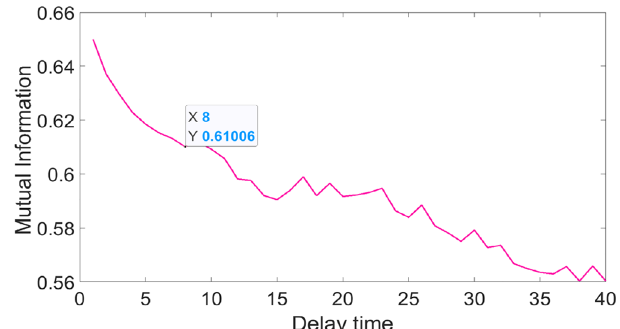
Figure 10. Time delay curve.